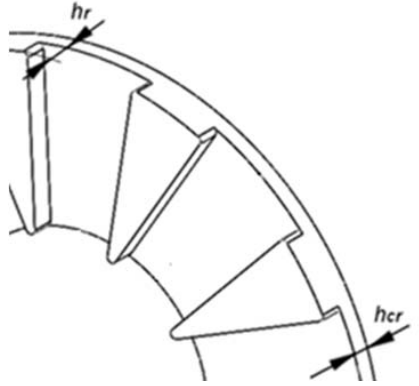
Figure 7. Rotor section showing disposition and dimensions of rotor poles.